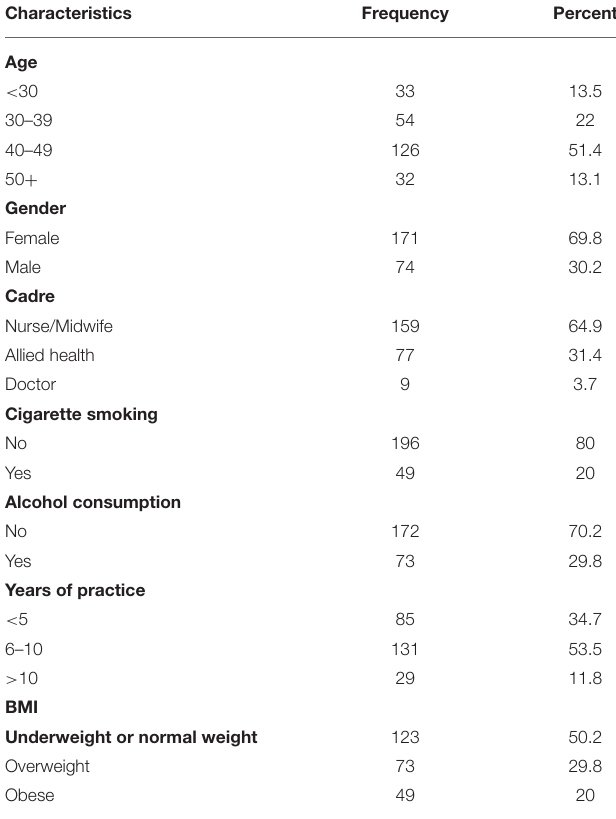
TABLE 1 | Sociodemographic characteristics of respondents. Characteristics